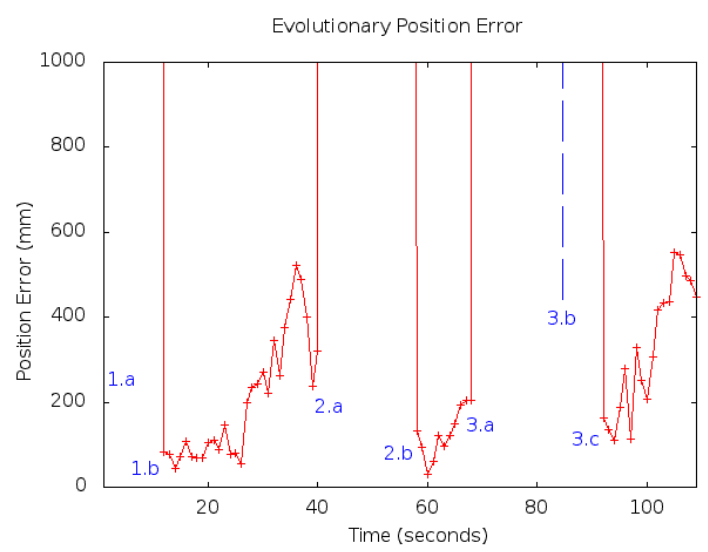
Figure 22. Position error over